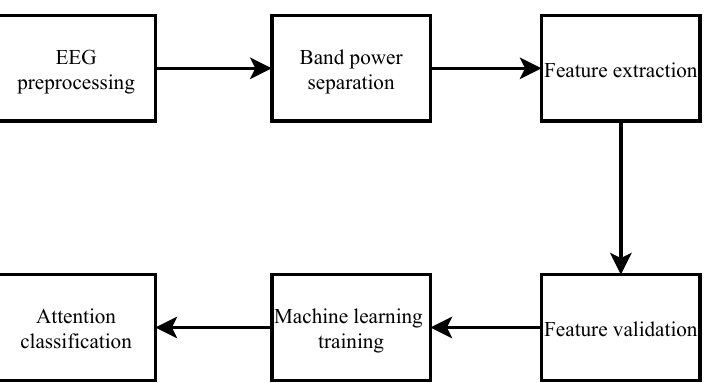
Figure 5. Block diagram of the proposed method. The first stage is signal preprocessing, after the band power separation, and then the feature extraction stage. Next is the feature validation process, the machine learning training stage, and finally, the attention quantification